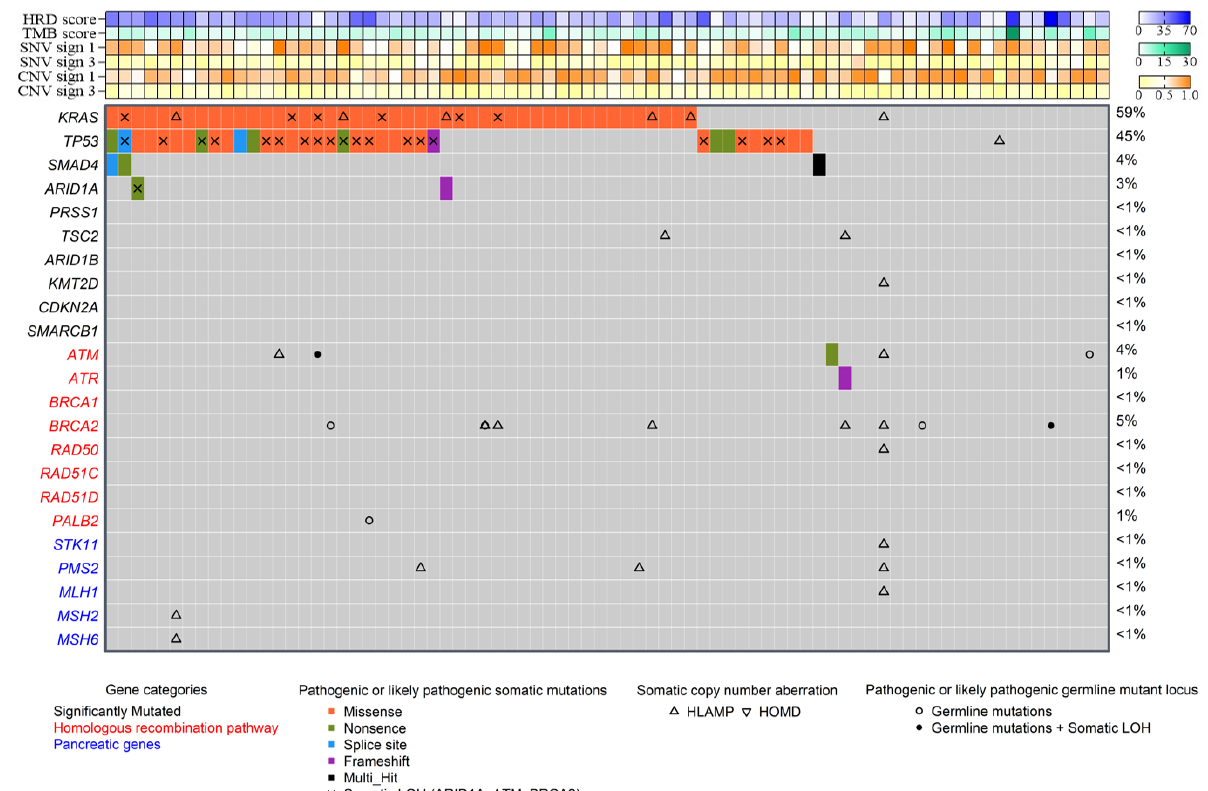
Figure 1. Landscape of genomic mutations in the whole population ( n = 78 samples). Only pathogenic or likely pathogenic somatic and germline mutations are presented in this landscape. For somatic mutations, we selected those most frequent in the whole cohort, genes involved in the homologous recombination pathway, and genes known to be characteristic of pancreatic tumor. Information about somatic copy number alterations was added. The LOH is shown for all germline mutations but only for some somatic mutations (ARID1A, ATM, and BRCA2). The percentages of patients carrying a somatic or germline mutation in the cohort are shown at the left. At the top, for each sample, expressions of SNV and CNV signatures 1 and 3 are shown, as well as the TMB without splicing regions and HRD scores. TMB: tumor mutational